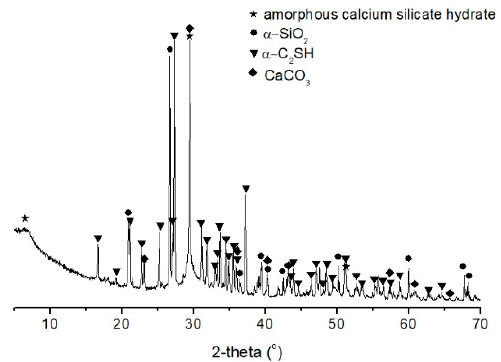
Figure 2. XRD pattern of synthesized calcium silicate hydrate powder.